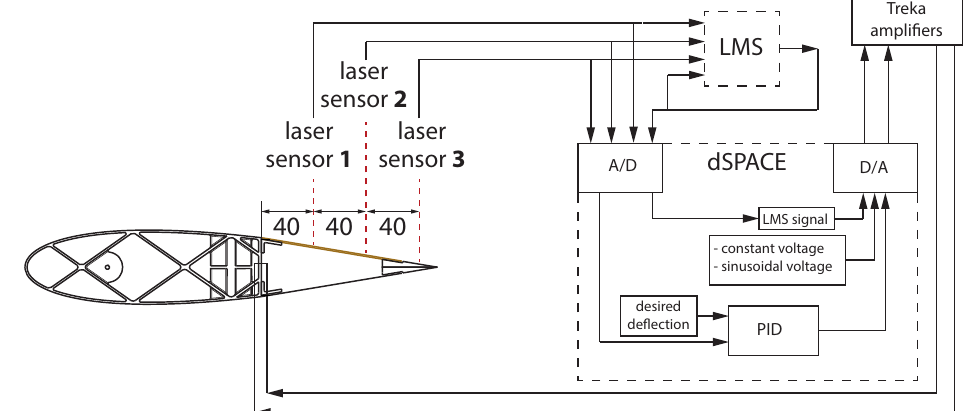
Figure 6. Experimental setup block scheme (dimensions in